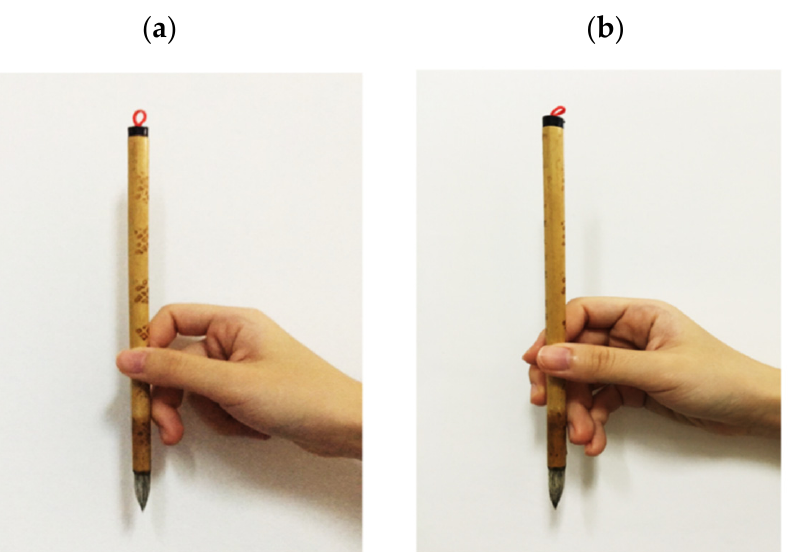
Figure 2. The two typical finger grips for manipulating the Chinese brush in the study. ( a ) Three- finger grip; ( b ) Five-finger grip.